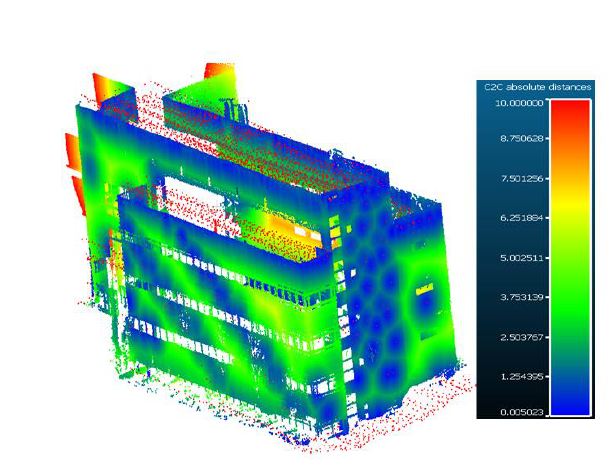
Figure 10: The result of ICP